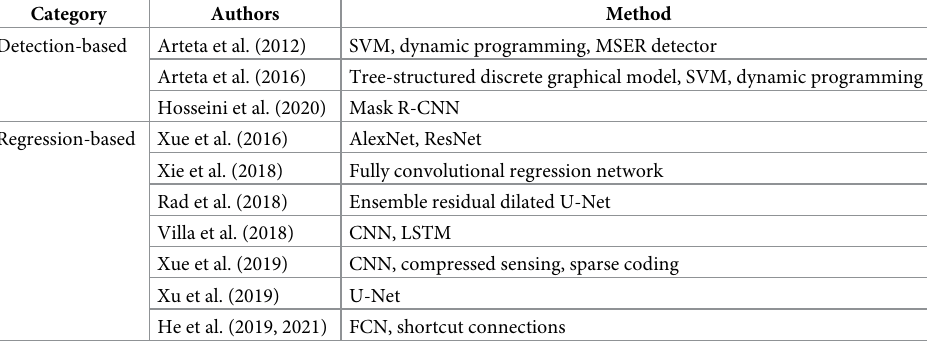
Table 1. A summary of the cell counting